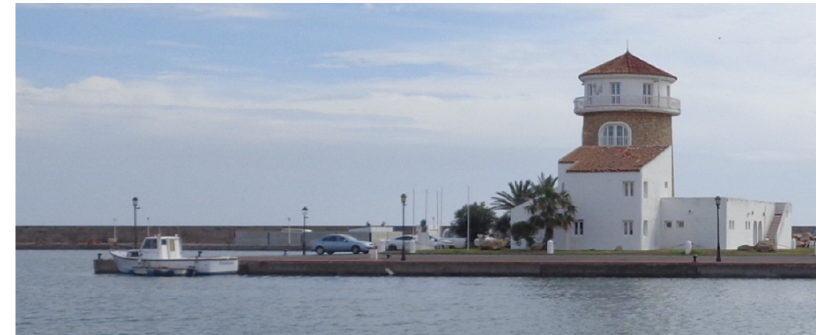
Figure 9. Port office as a landmark, Almerimar (Almería), ES. Figure 8. Port office as a landmark, Almerimar (Almer í a), ES. Figure 3. Figures 4–9 location map. Figure 8. Incompatibility between pedestrian and vehicle traffic, Almerimar (Almería), ES.